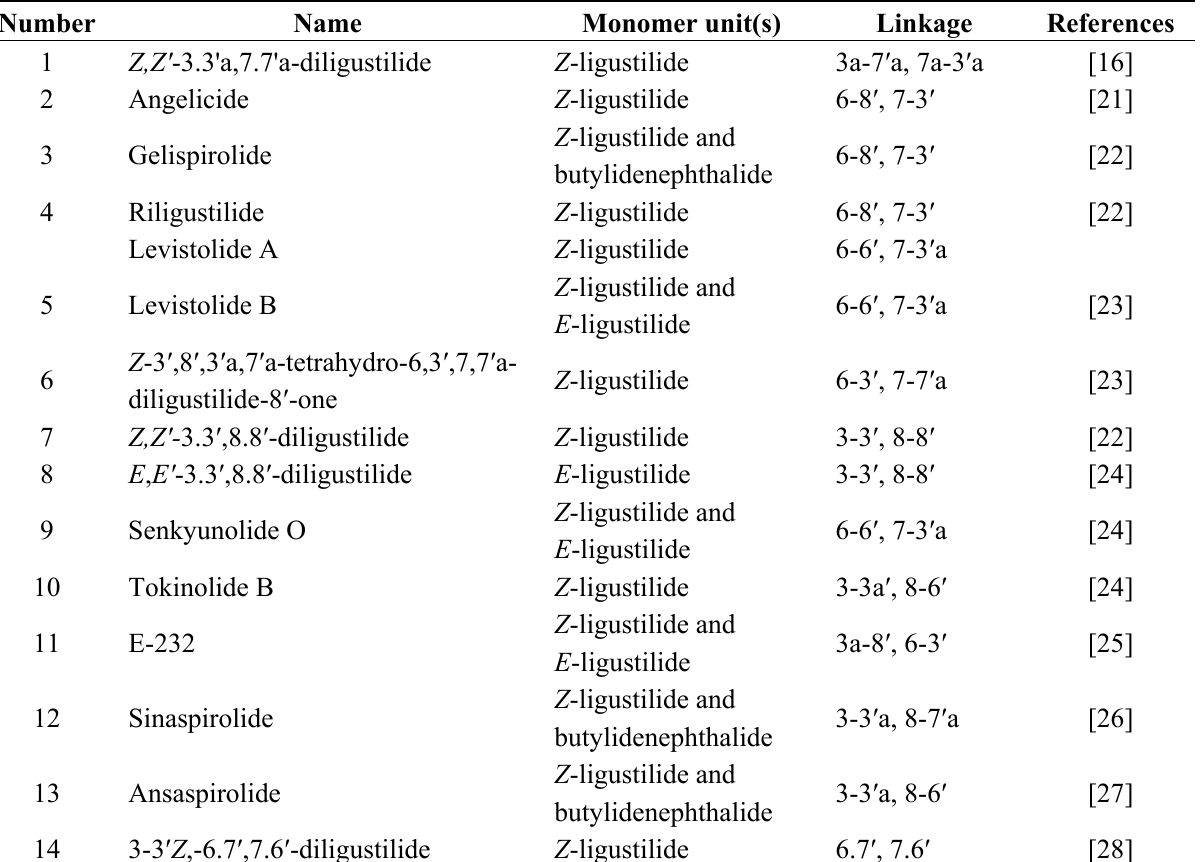
Table 2. Overview of known phthalide dimers, which have been isolated from A. sinensis